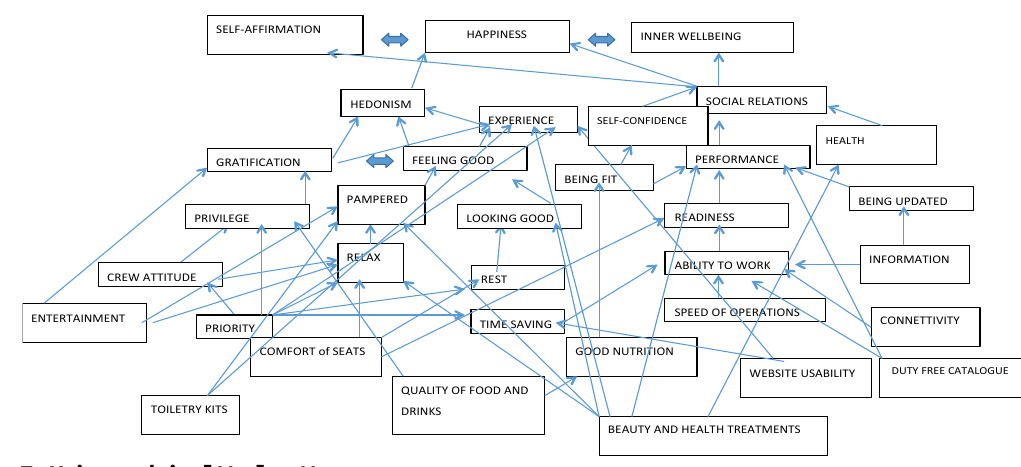
Figure 1: Hierarchical Value